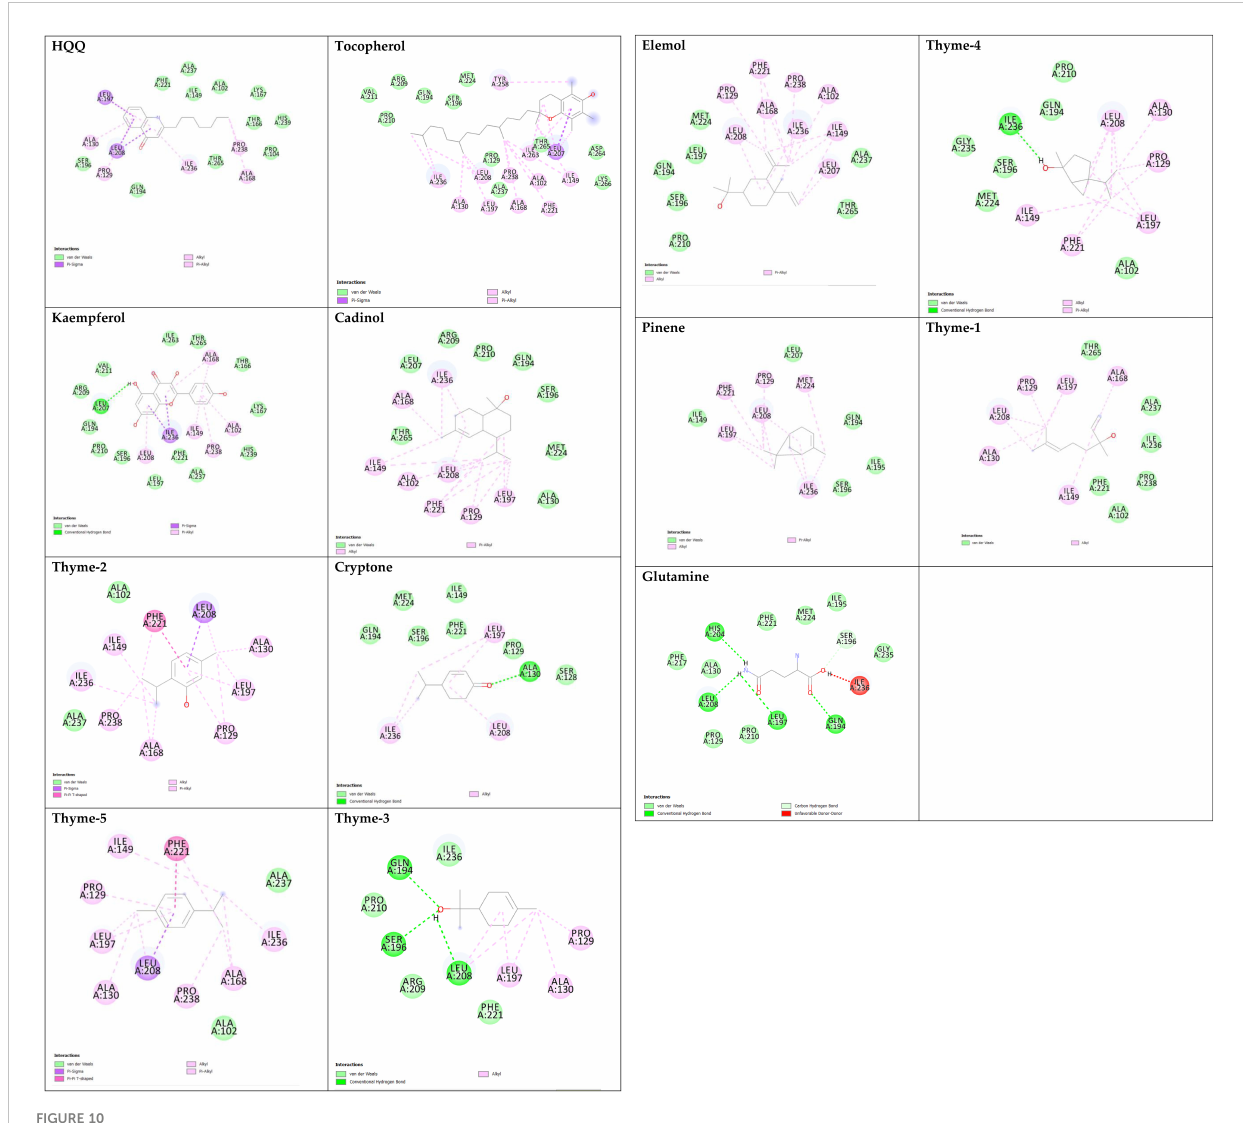
FIGURE 10 2D ligands interaction diagram of the proposed molecules with